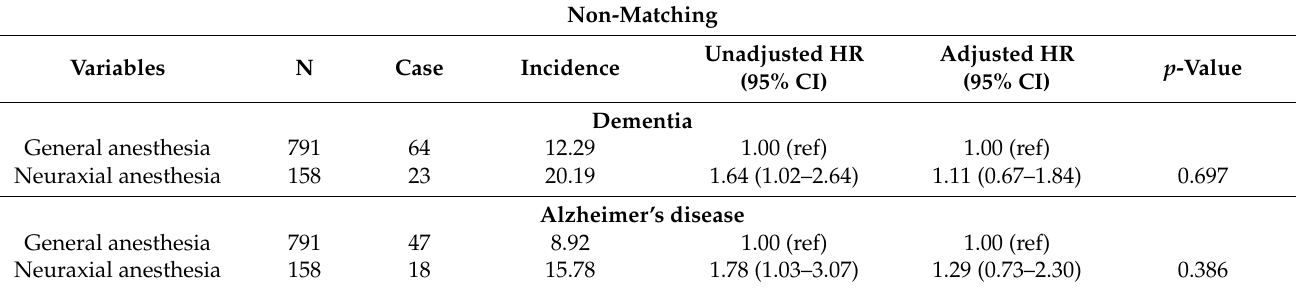
Table A7. Incidence per 1000 person-years and HR (95% CI) of dementia according to anesthesia method of two or more